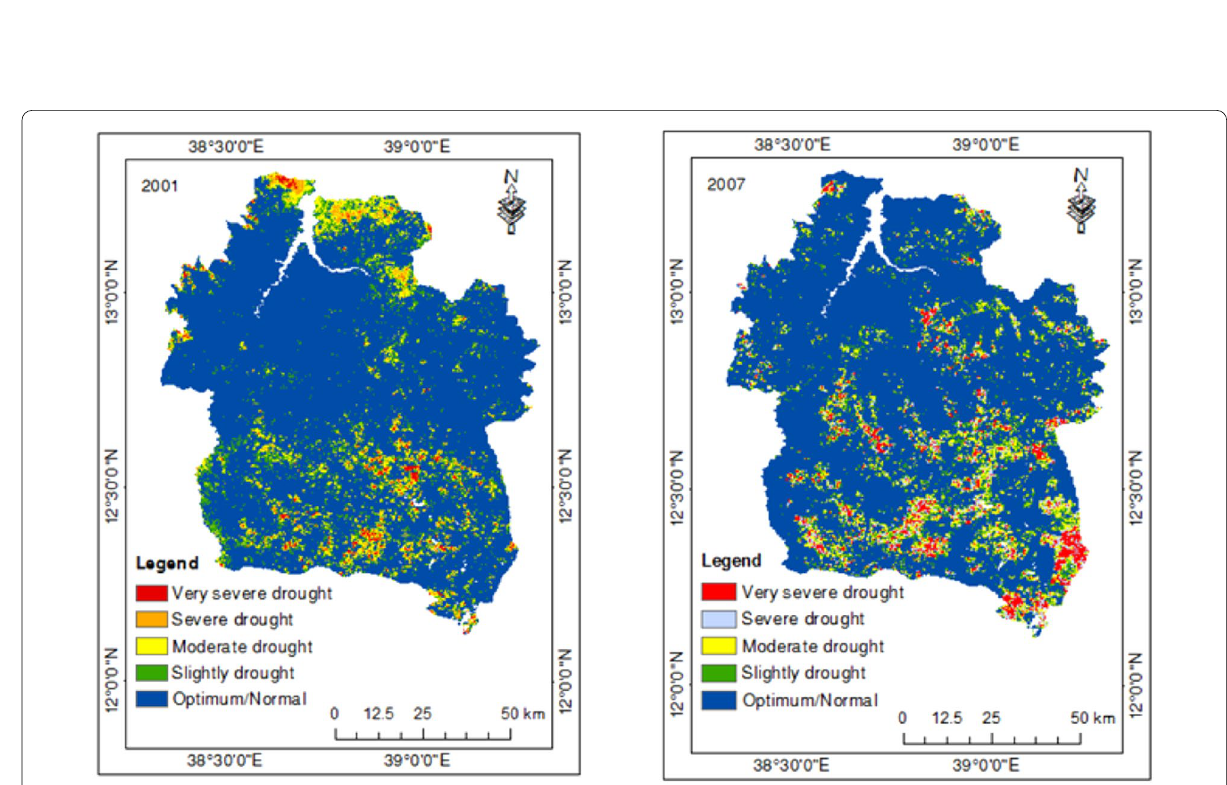
Fig. 8 Spatial pattern of agricultural drought expressed as VCI during wet year 2001and